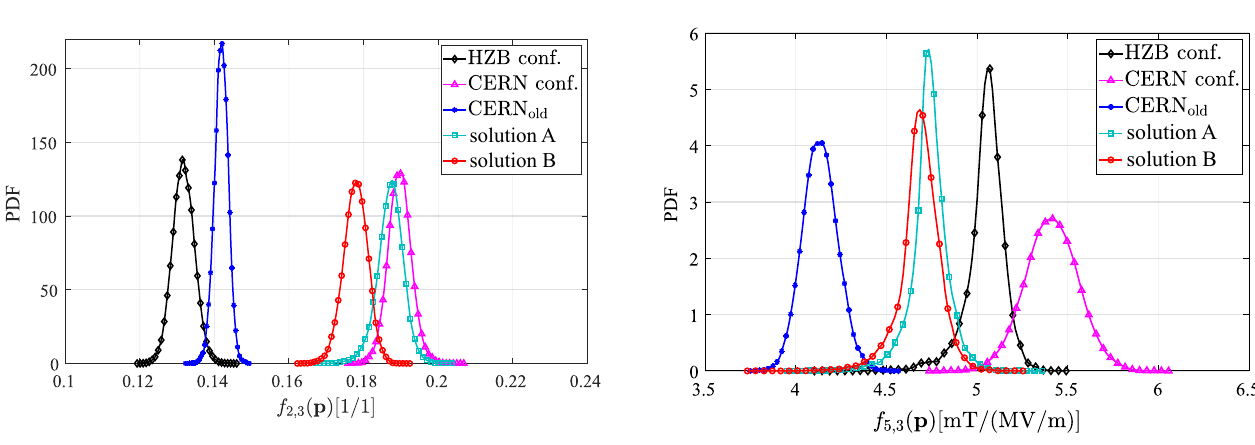
FIG. 11. Probabilistic density function for the homogeneity factor.